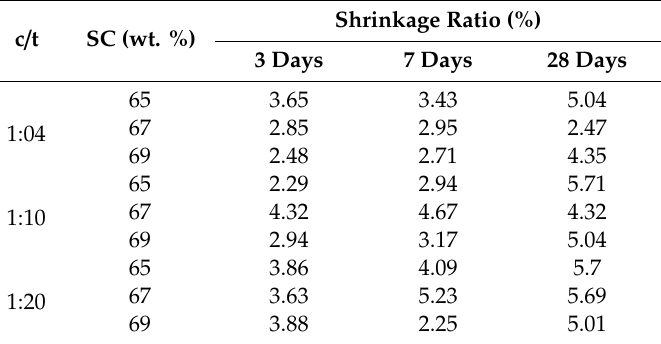
Table 3. Shrinkage rate of di ff erent CTB